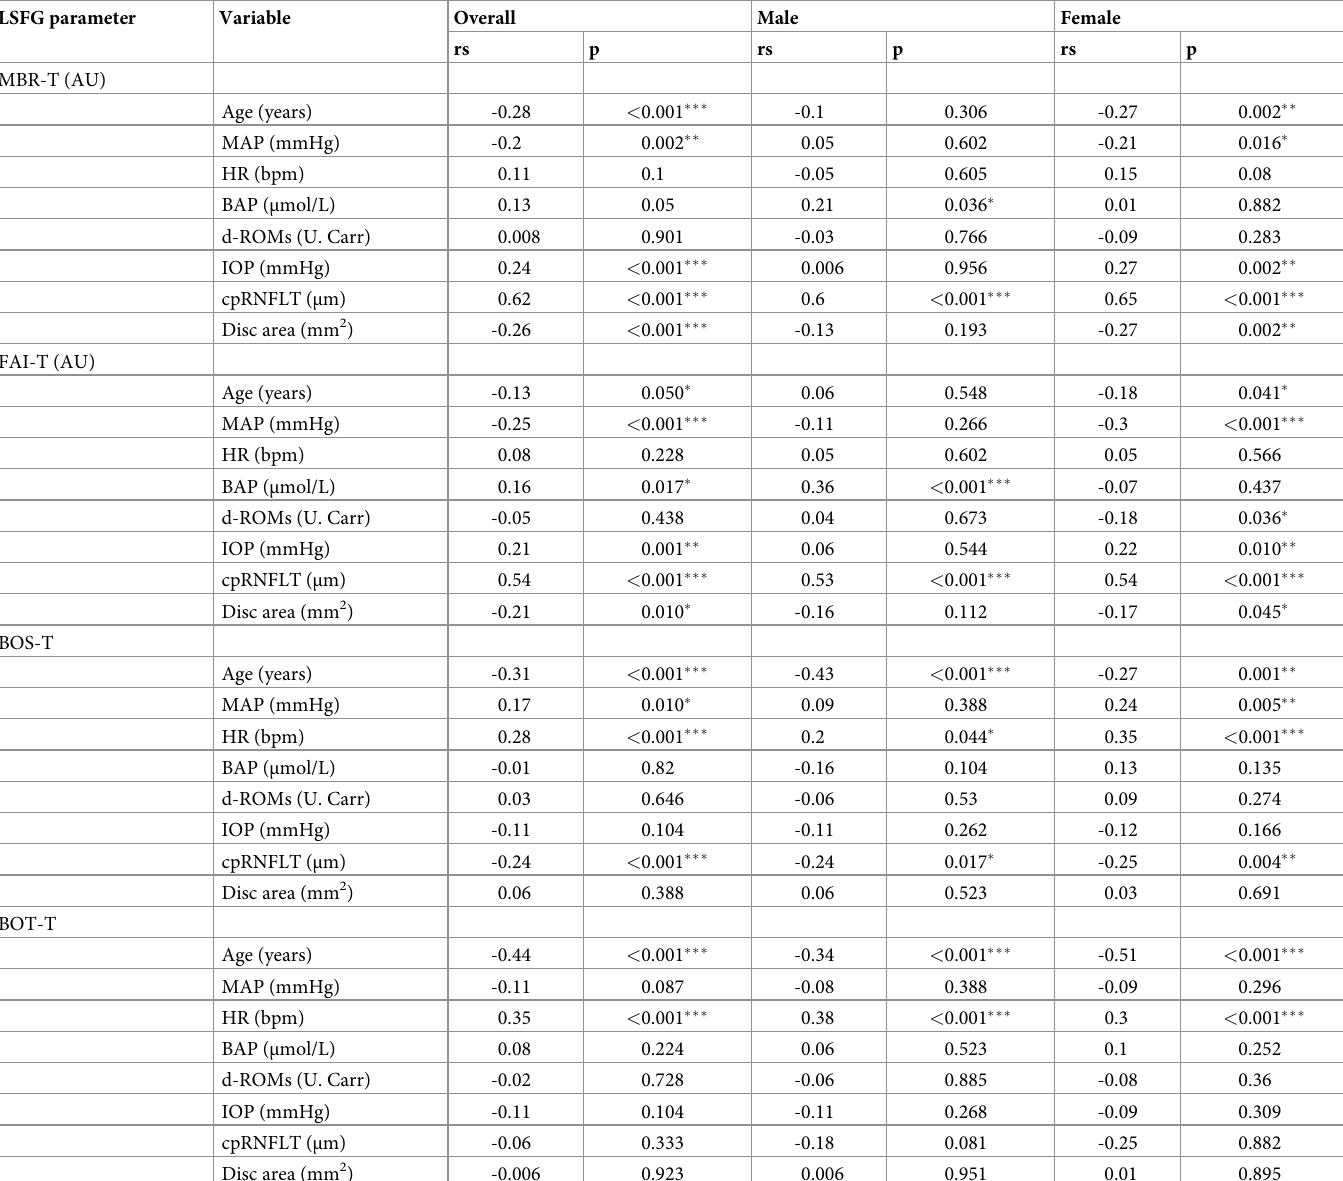
Table 3. Spearman’s correlation coefficient between MBR-T, pulse waveform parameters, and each variable. LSFG parameter